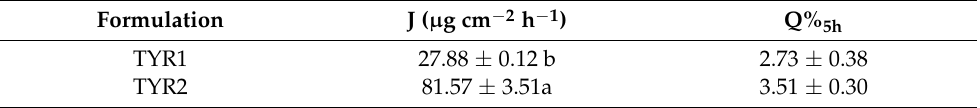
Table 1. Parameters related to permeation of tyrosol from chitosan vehicles through tomato peel (mean ± SE, n = 6). Different letters indicate statistically significant differences between formula- tions, according to Studen t’s two -tailed unpaired t -test ( p < 0.05). TYR1 and TYR2, 1.0% and 2.0% w/w tyrosol, respectively.